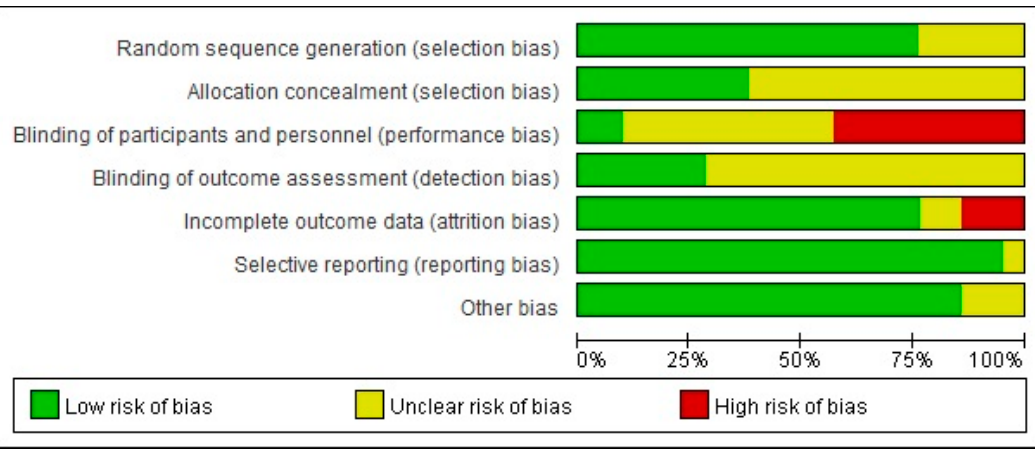
Figure 3. Risk of bias summary.